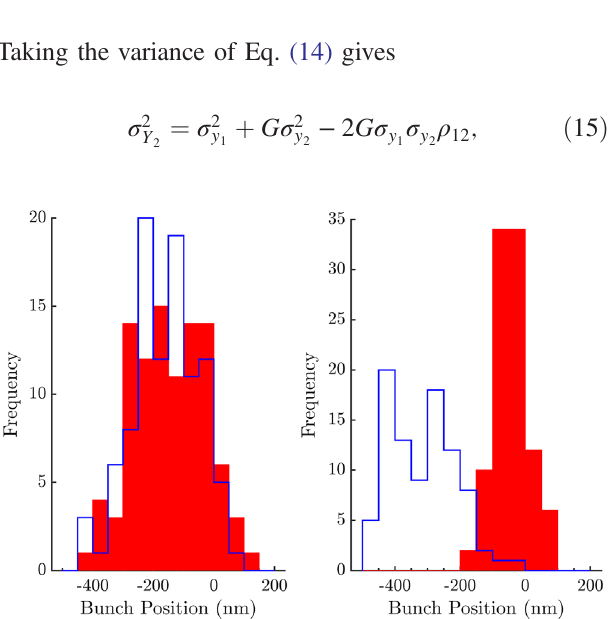
FIG. 16. Distributions of bunch positions measured at IPC, for bunch-1 (left) and bunch-2 (right) with feedback off (blue) and feedback on